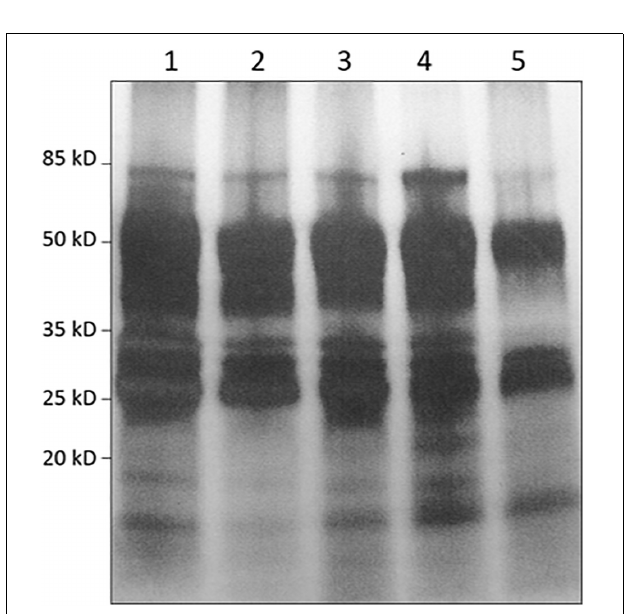
FIGURE 7 | Highlighting of the capacity of Nepenthes pitcher to renew its digestive pools after several collects and replacements of liquid by an alkaline buffer via SDS-PAGE analysis. (1) Secretion pool after opening pitcher and before the first replacement; (2) Secretion pool 3 days after the first replacement of digestive liquid by a buffer; (3) Secretion pool 3 days after the second replacement; (4) Secretion pool 3 days after the third replacement; (5) Secretion pool 3 days after the fourth